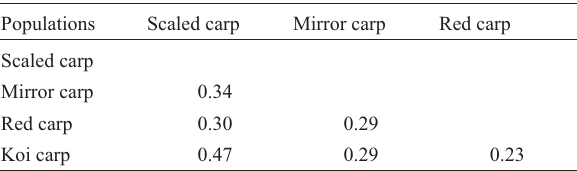
Table 5 - Summary of Nei’s (1972) genetic distance values between four common carp strains.